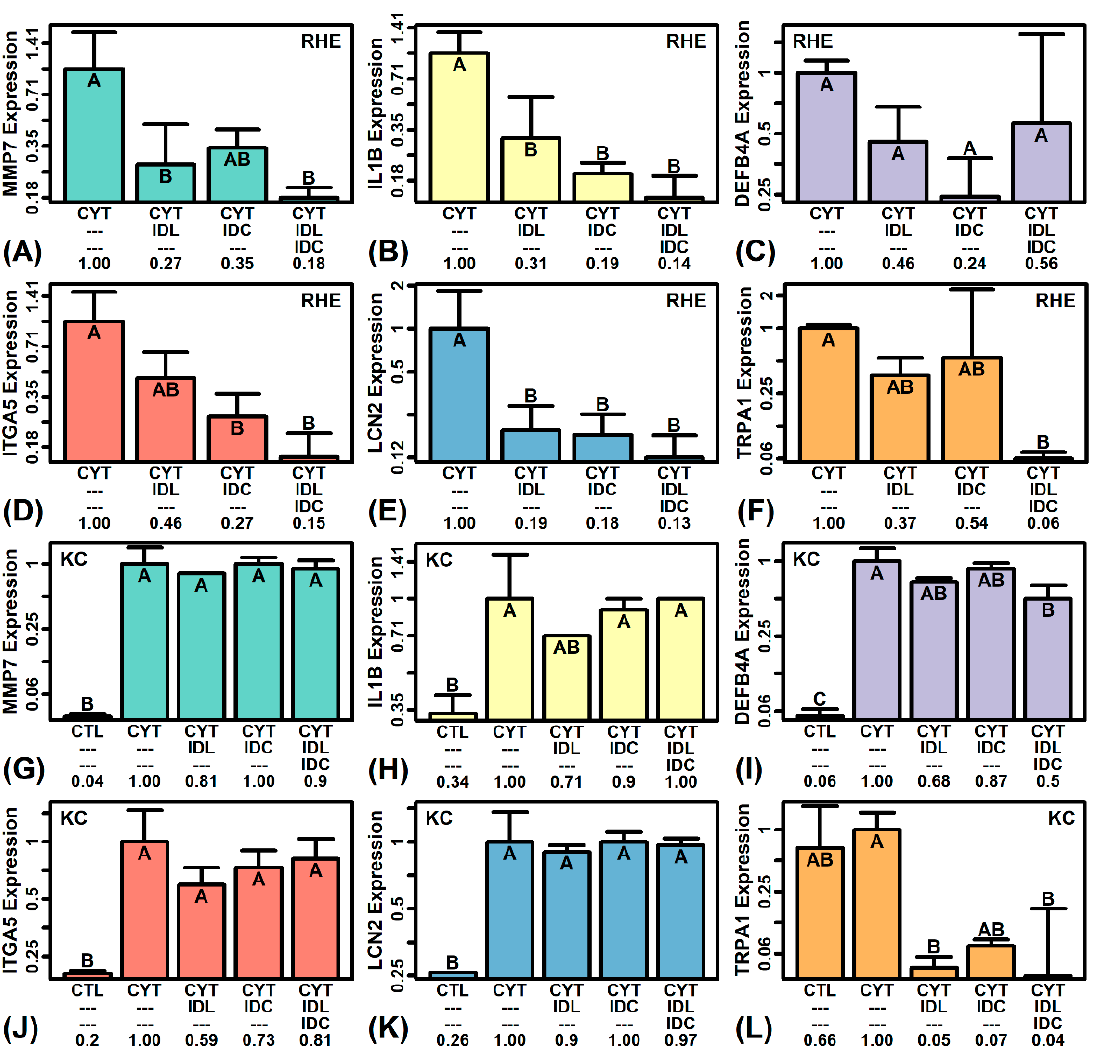
Figure 5. RT-PCR analyses. ( A , G ) MMP7 . ( B , H ) IL1B . ( C , I ) DEFB4A . ( D , J ) ITGA5 . ( E , K ) LCN2 . ( F , L ) TRPA1 . Experiments were performed using RHE tissue ( A – F , n = 3 per treatment) and HaCaT KCs ( G – L , n = 2 per treatment). Average relative expression of each gene is shown (± 1 standard error). Groups without the same letter differ significantly ( p < 0.05, Fisher’s least significant difference (LSD)). The average FC for each group is listed ( bottom margin ). Expression of 18S ribosomal RNA (18S) was used a reference. For RHE experiments ( A – F ), analyses were performed using the same RNA samples analyzed by microarray.